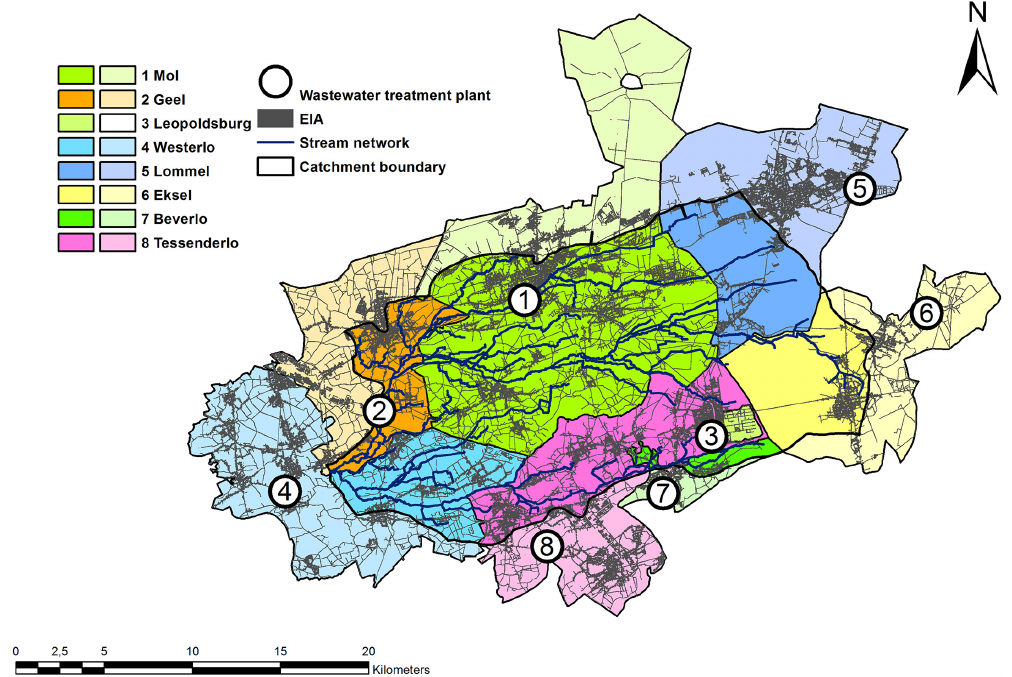
Fig. 2. Overview of the different WWTPs and their WWCRs that are situated within the Grote Nete catchment (1–3) as well as the WWTPs that receive wastewater from impervious areas that are situated within the Grote Nete catchment but discharge into another catchment (4–8). Parts of the WWCR that are situated within the natural catchment boundary are shown with a brighter shade, illustrating the discrepancy between the areas covered by the natural catchment and the sewer